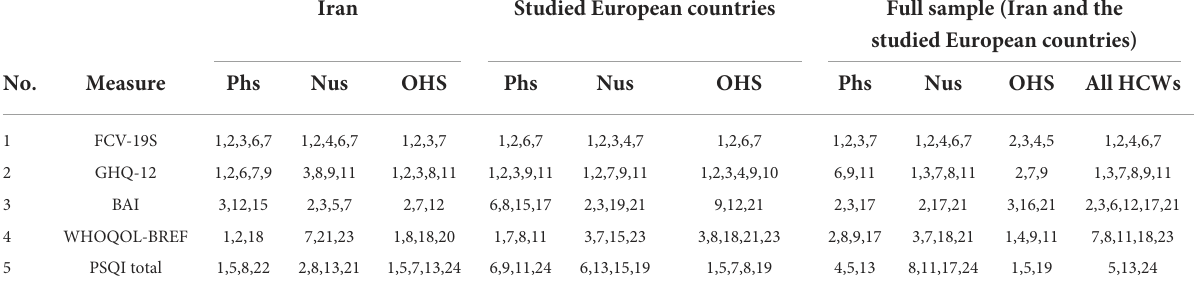
TABLE 4 Normality test of the recorded scores using Kolmogorov–Smirnov (K-S) test. Iran Studied European countries Full sample (Iran and the studied European